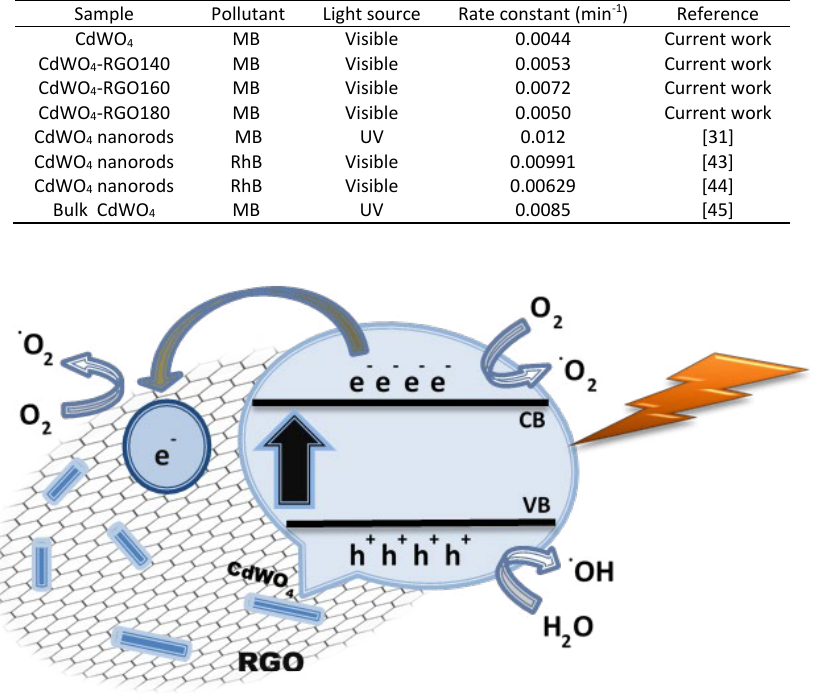
Fig. 10. Schematic presentation of the photocatalytic reactions on the nanocomposite